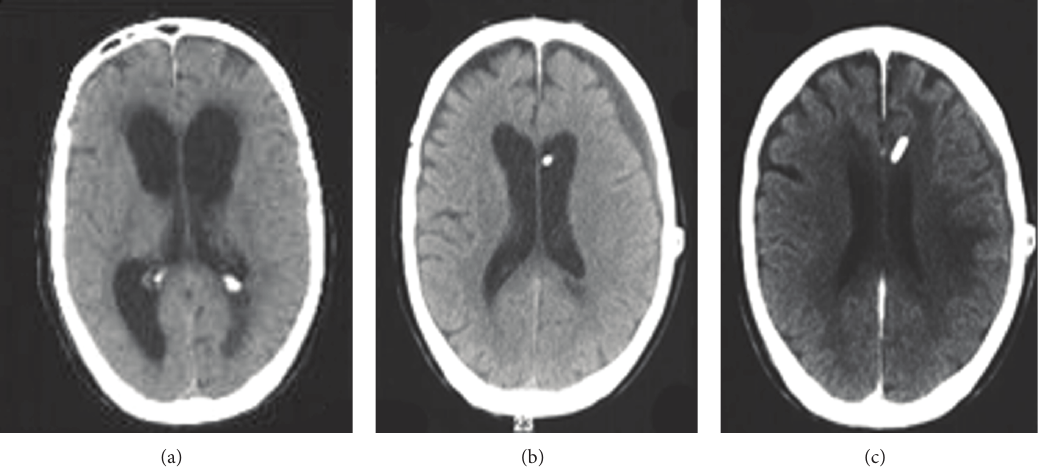
Figure 1: (a) Preoperative CT scan showing enlarged ventricular system. (b) CT scan four weeks after insertion of a shunt, subdural hygroma can be observed (c) CT scan 6 weeks after the adjustment of the opening pressure. The hygroma had reabsorbed.